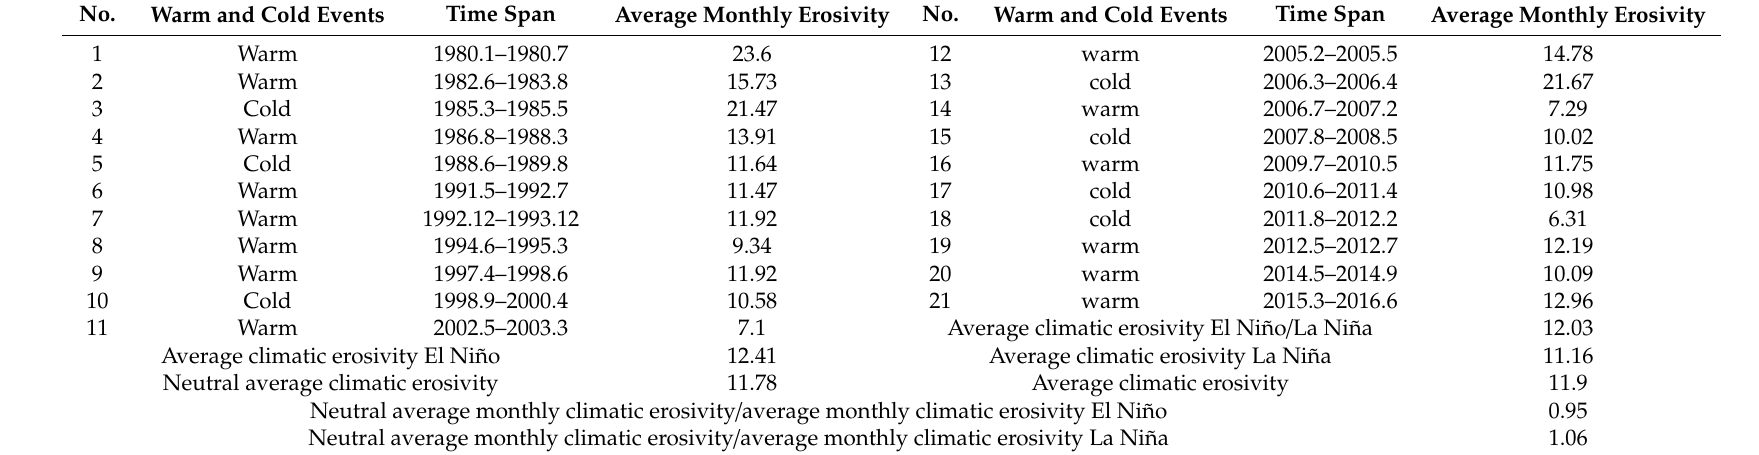
Table 2. Average monthly climatic erosivity during El Niño and La Niña events from 1980 to